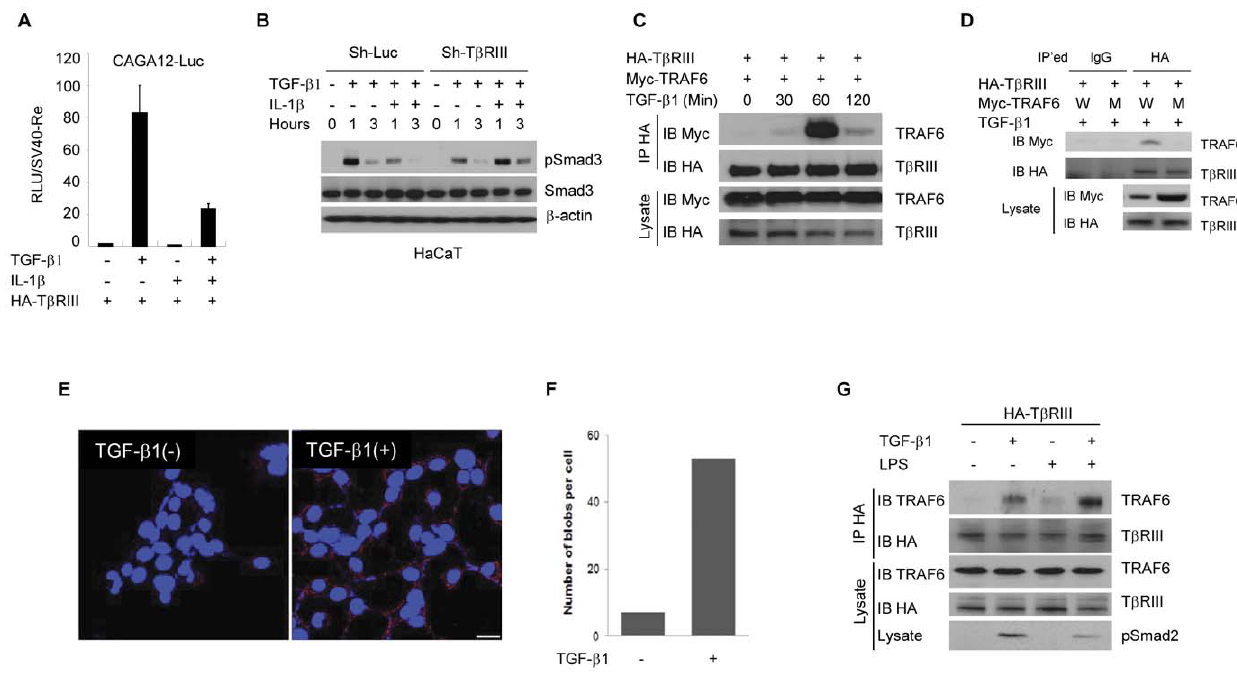
Figure 3. TRAF6 forms a complex with T b RIII in response to TGF- b 1. ( A ) CAGA12-Luciferase assays were performed in HepG2 cells. The plasmids encoding HA-T b RIII, TRAF6, CAGA12-Luc, and Renilla-luc reporter gene were transfected as indicated and, on the next day, TGF- b 1 (0.4 ng/ ml) and/or IL-1 b (20 ng/ml) was added for 16 hours. The obtained relative luciferase units(RLU) were normalized by renilla luciferase activities. ( B ) Using the control and T b RIII knock-down HaCaT cells, TGF- b 1 (0.4 ng/ml) and/or IL-1 b (20 ng/ml) were treated as shown for up to 3 hours. The level of total Smad3 and phospho-Smad3 protein was detected by immunoblotting. For the control of equal loading, b -actin was used. ( C ) HEK293 cells stably expressing HA-T b RIII were transfected with Myc-Traf6 plasmids and then treated with TGF- b 1. Cells were harvested at various times and were subjected to immunoprecipitation with anti-HA antibody. Co-immunoprecipitated TRAF6 was detected with anti Myc antibody. ( D ) Complex formation ability between T b RIII and TRAF6 wild-type or the TRAF6 (C85A/H87A) E3 ligase mutant was compared after TGF- b stimulation for an hour. ( E ) According to the manufacturer’s protocol, interaction was visualized by in situ proximity ligation assay (O-link) with proximity probes directed against TRAF6 and T b RIII using Alexa 555 labeling (red). Endogenous TRAF6 was co-localized with HA-T b RIII along the plasma membrane in the presence of TGF- b (red blobs). Bar=2.5 m m. ( F ) Quantification of blobs per cell was carried out by semi-automated image analysis using the freeware software BlobFinder V 3.0. ( G ) HA-T b RIII-stably expressing 4T07 mouse mammary cancer cells were treated with TGF- b and LPS for one hour. Co- immunoprecipitation was carried out using anti-HA antibody to query interaction with endogenous TRAF6. The results are representative of three independent